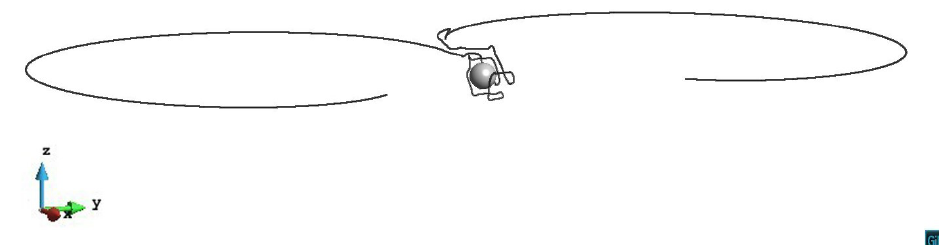
Figure 5. The dislocation line with the primary slip plane z / R = 0.6 leaving a helix around the precipitate. The plastic strain ε = 6.19 × 10 − 4 .